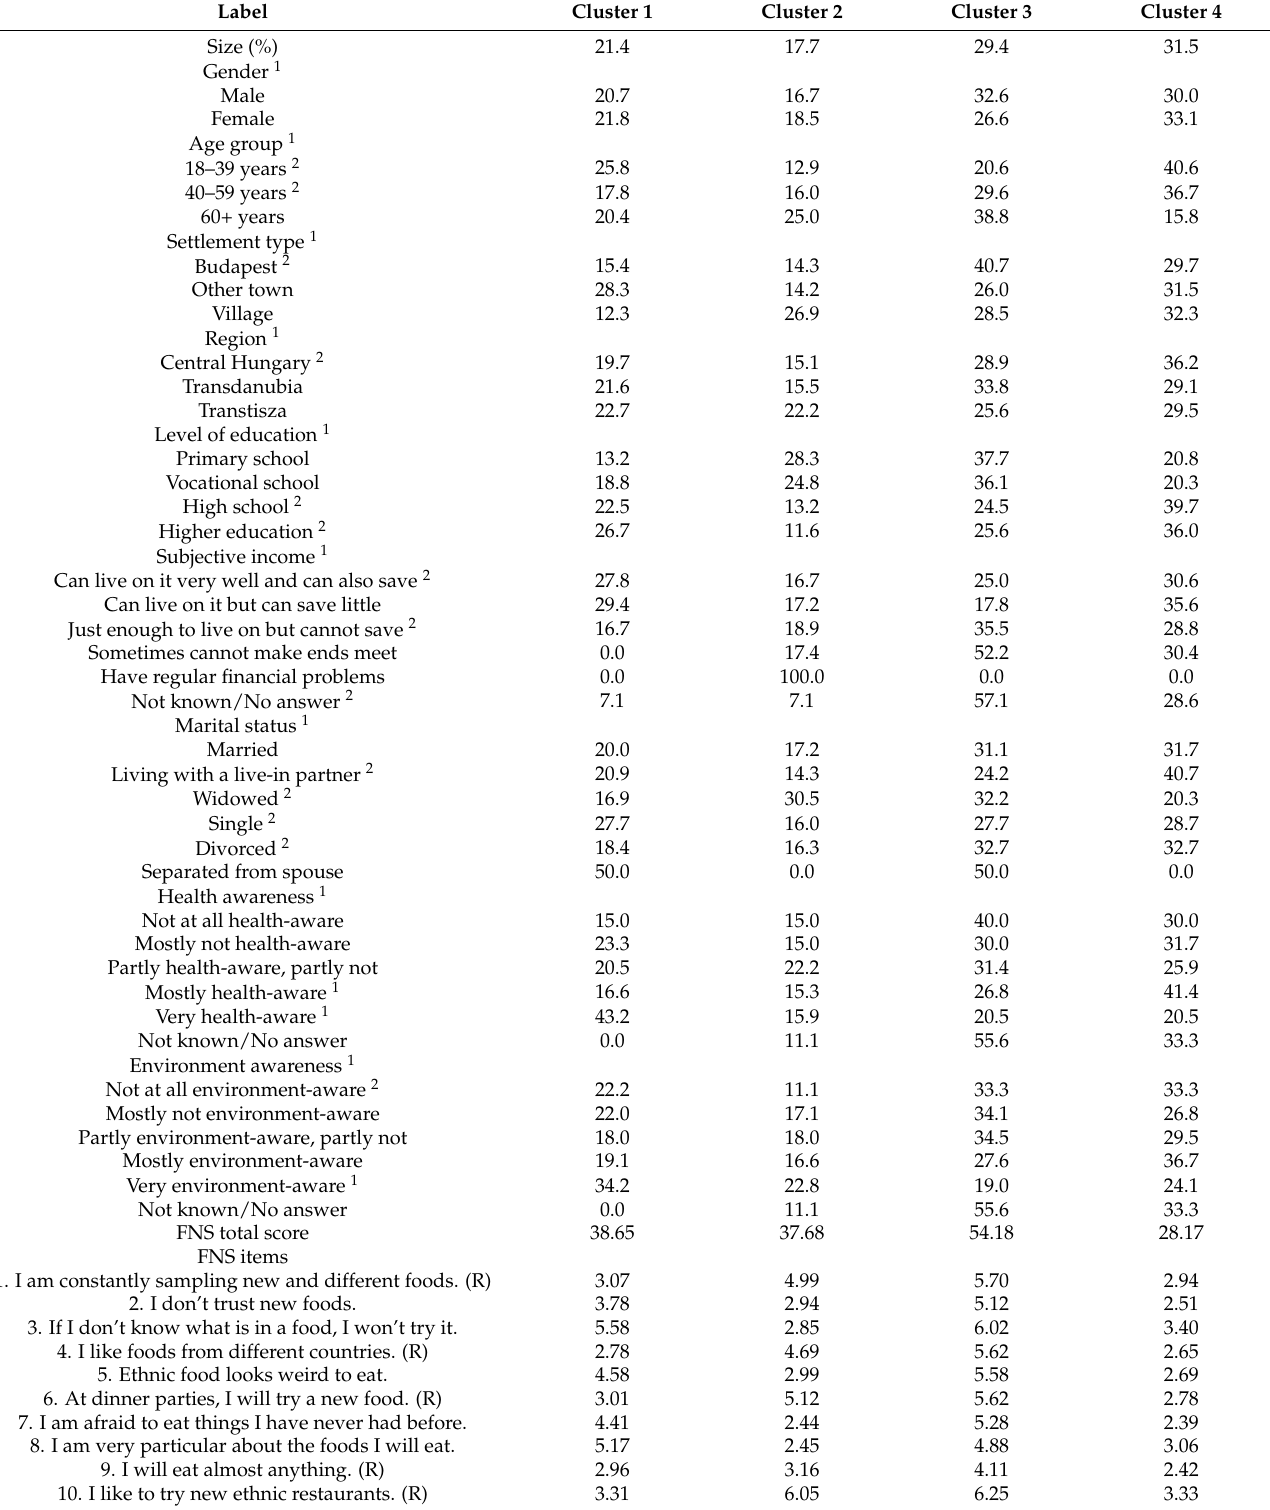
Table 8. Distribution of clusters according to background variables (%) and mean FNS scores of clusters ( n = 476).